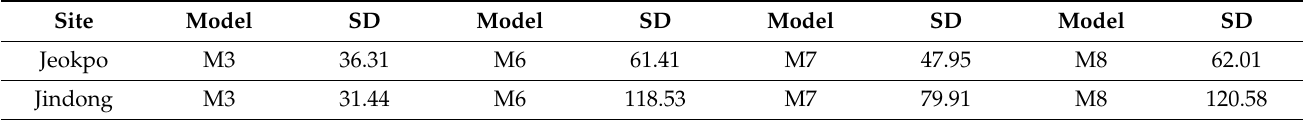
Table 11. SD at Jindong and Jeokpo from the predicted total sediment load.